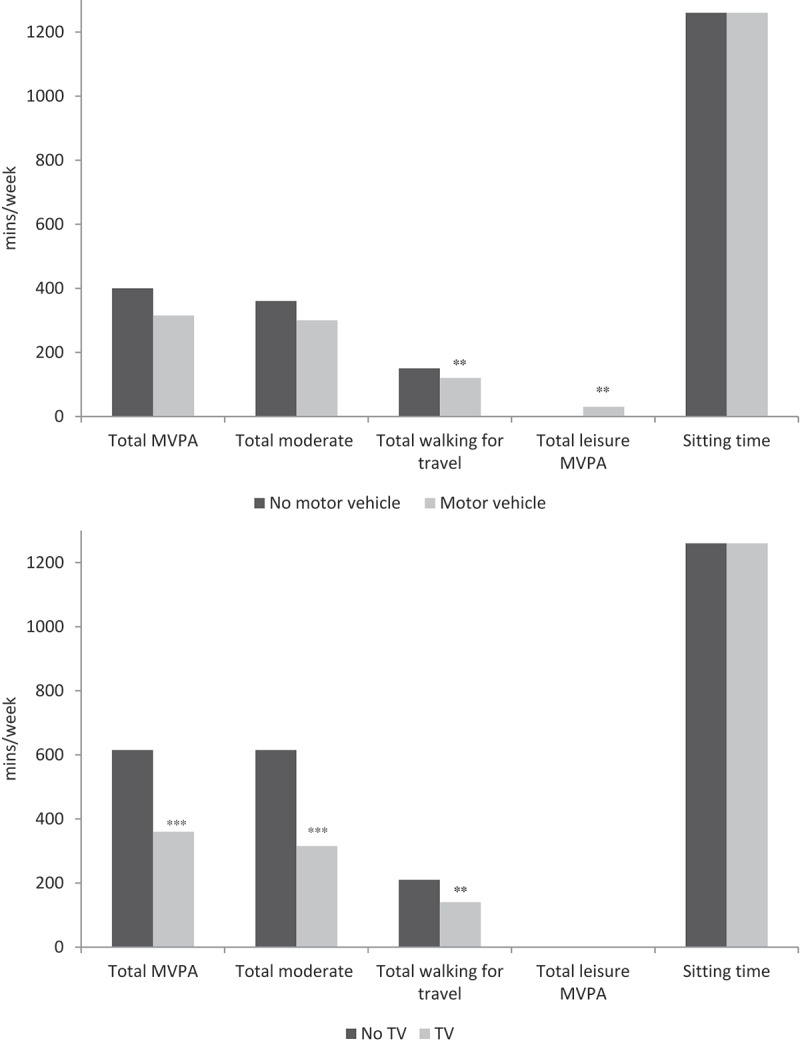
Body composition across body-size dissatisfaction groups. Source of data: Gradidge et al. (2015) [11]; ***p < 0.0005 vs women who desired to increase their body size.